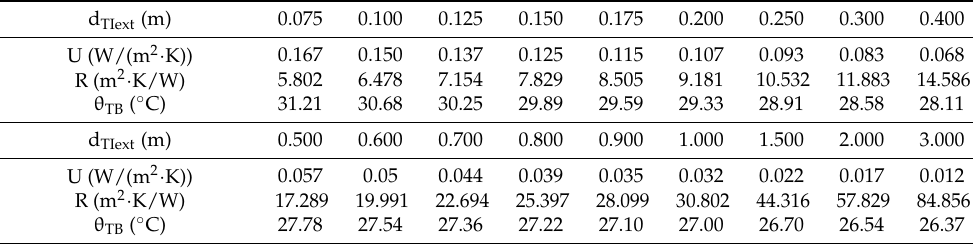
Table 2. Parameters during